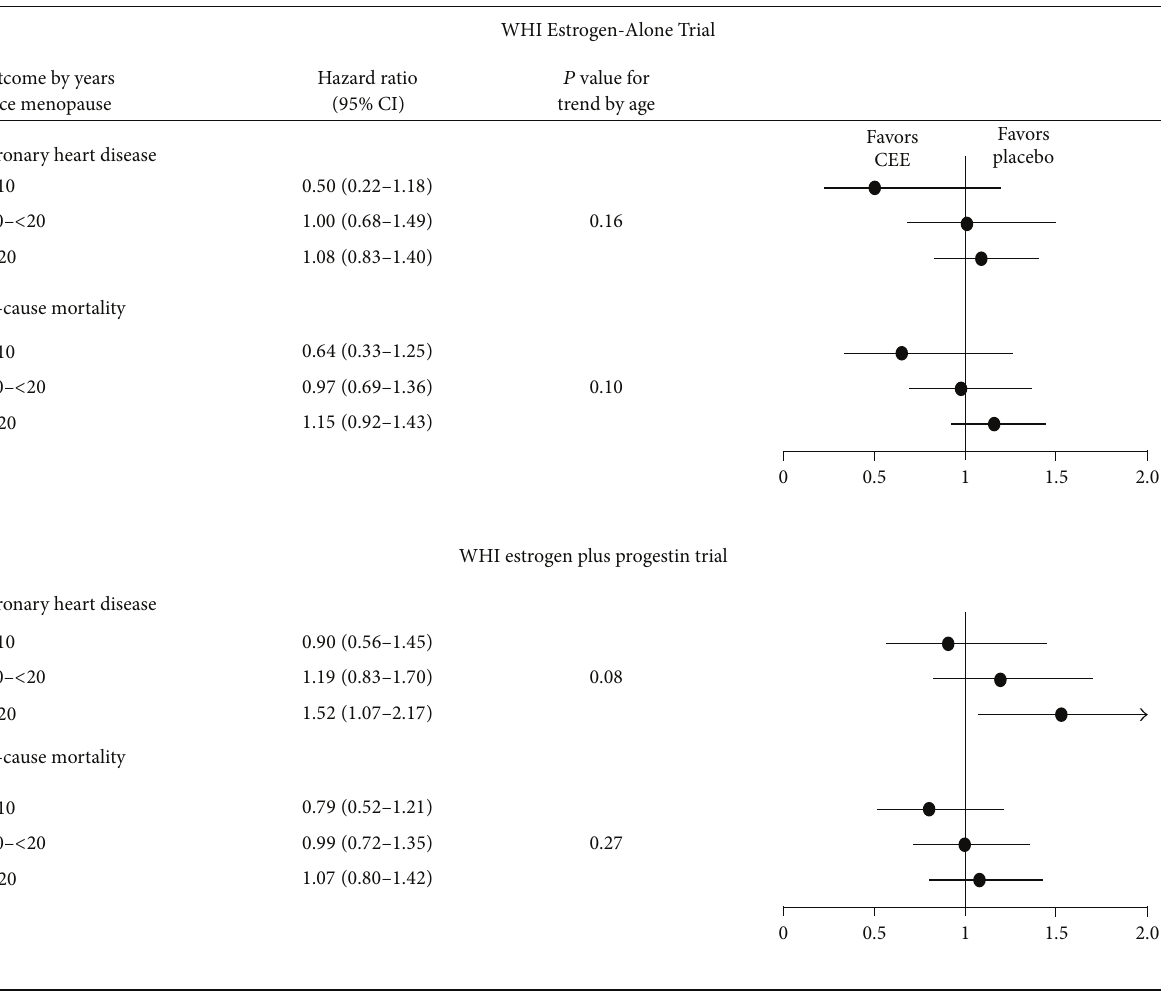
Figure3:InterventionphaseoutcomesbyyearssincemenopauseattrialentryofWHIEstrogen-AloneTrialandWHIestrogenplusprogestin trial. CEE: conjugated equine estrogens; WHI: Women’s Health Initiative. Sources for outcomes: [3,